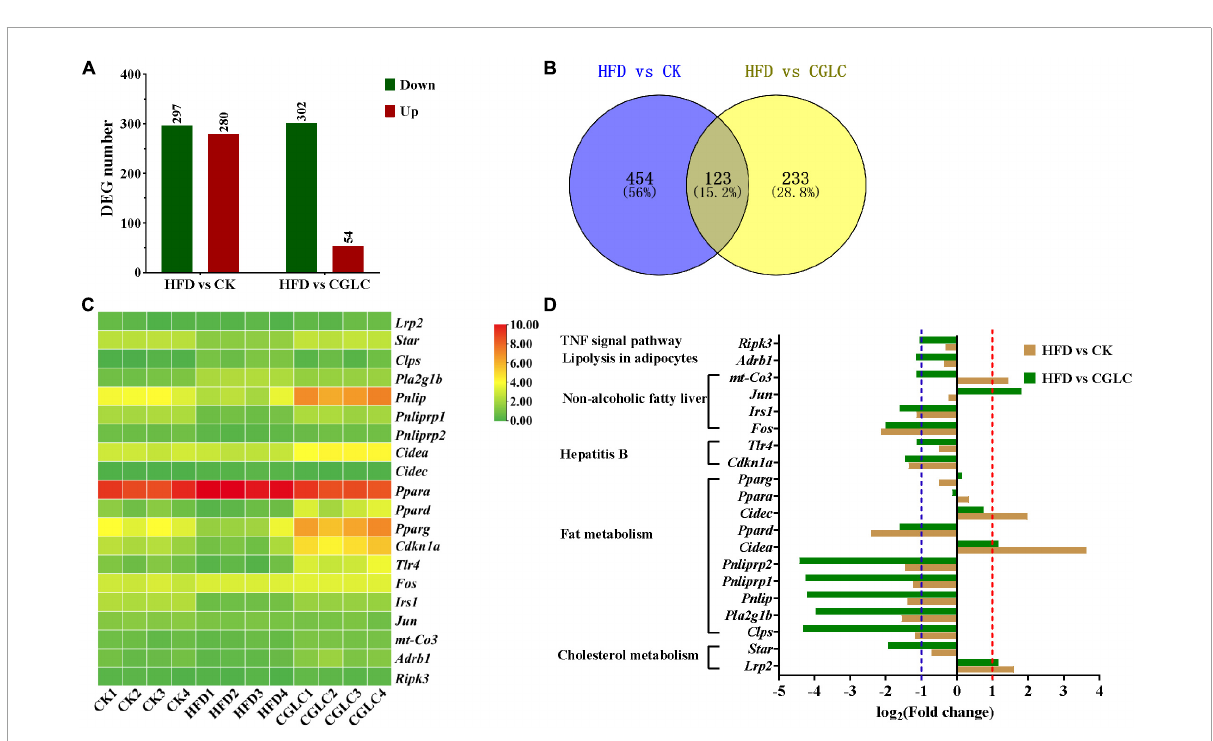
FIGURE7 Number distribution of DEGs in HFD vs CK and HFD vs CGLC (A) . Venn map showing DEG overlapping of two comparisons (B) . Heat map showing the log 2 (FPKM + 1) values of genes involved in fat and lipid metabolism in three group (C) . Fold changes of genes involved in fat and lipid metabolism in two comparisons (D) .